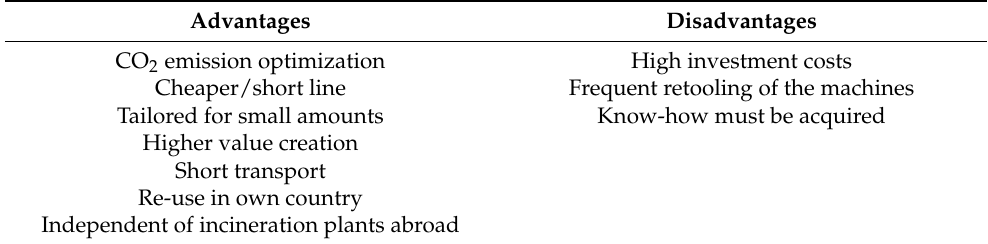
Table 3. Advantages and disadvantages of the proposed comprehensive waste treatment and recy- cling